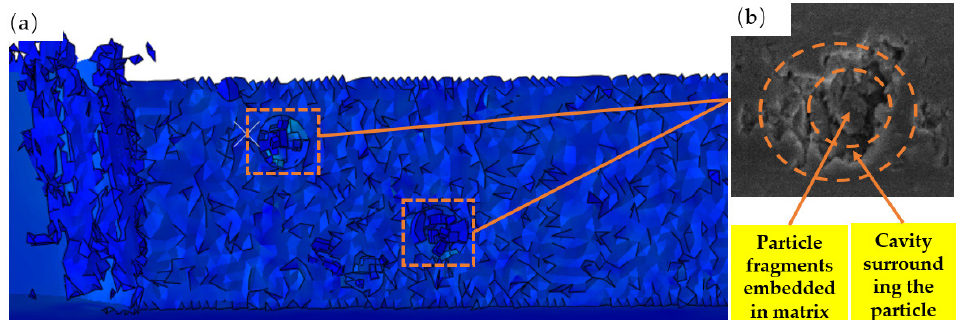
Figure 12. Machining surface shallow voids around intact particles: ( a ) simulated particles are removed to form a shallow cavity, and ( b ) the surface shallow voids around intact particles SEM image after turning to process.